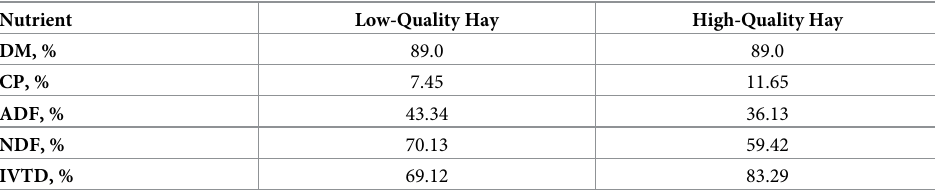
DM-dry matter; CP-crude protein; ADF-acid detergent fiber; NDF-neutral detergent fiber; IVTD– in vitro true